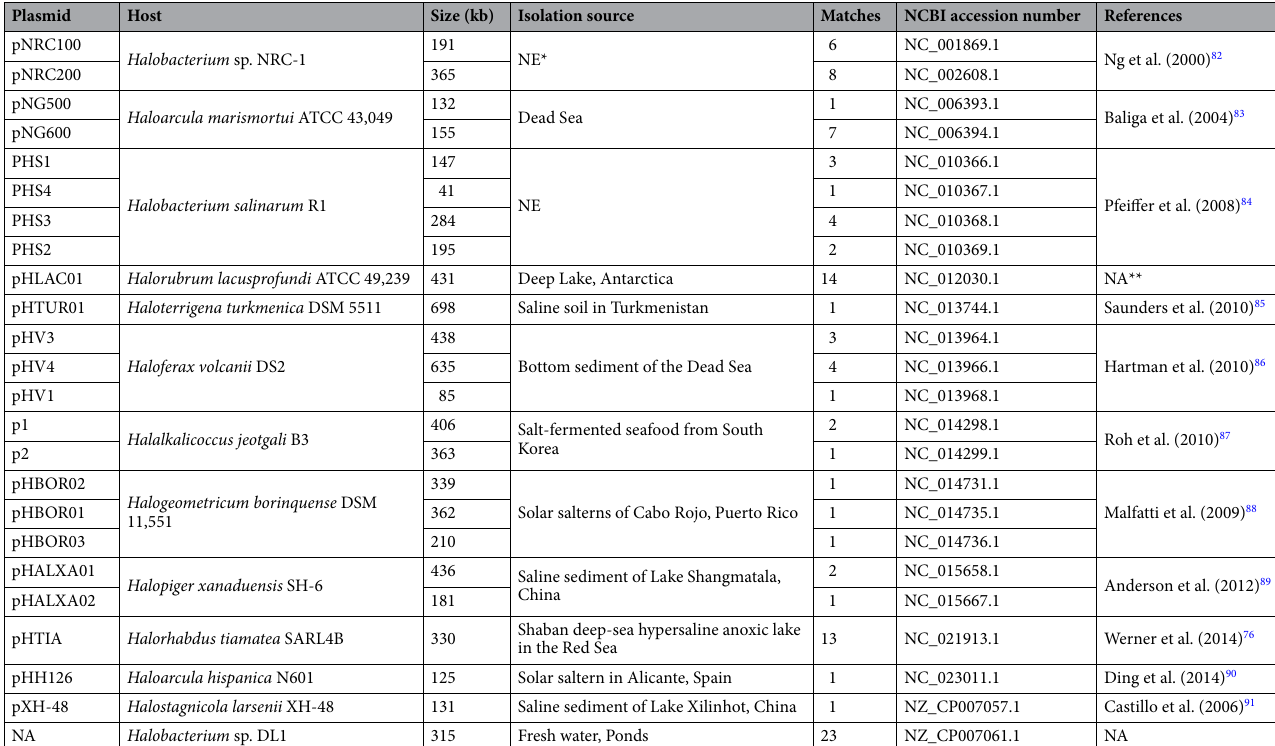
Table 3. Plasmid matches of the Diamante Lake plasmidome with entries derived from the NCBI database. * NE not specified, ** NA not